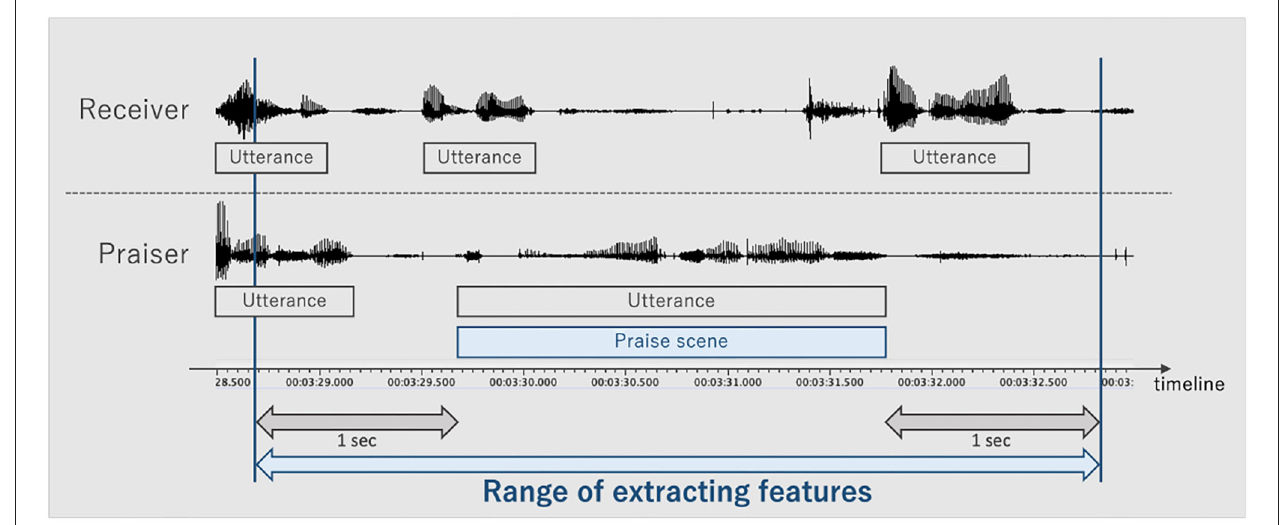
FIGURE 3 | Range for extracting features related to head and face